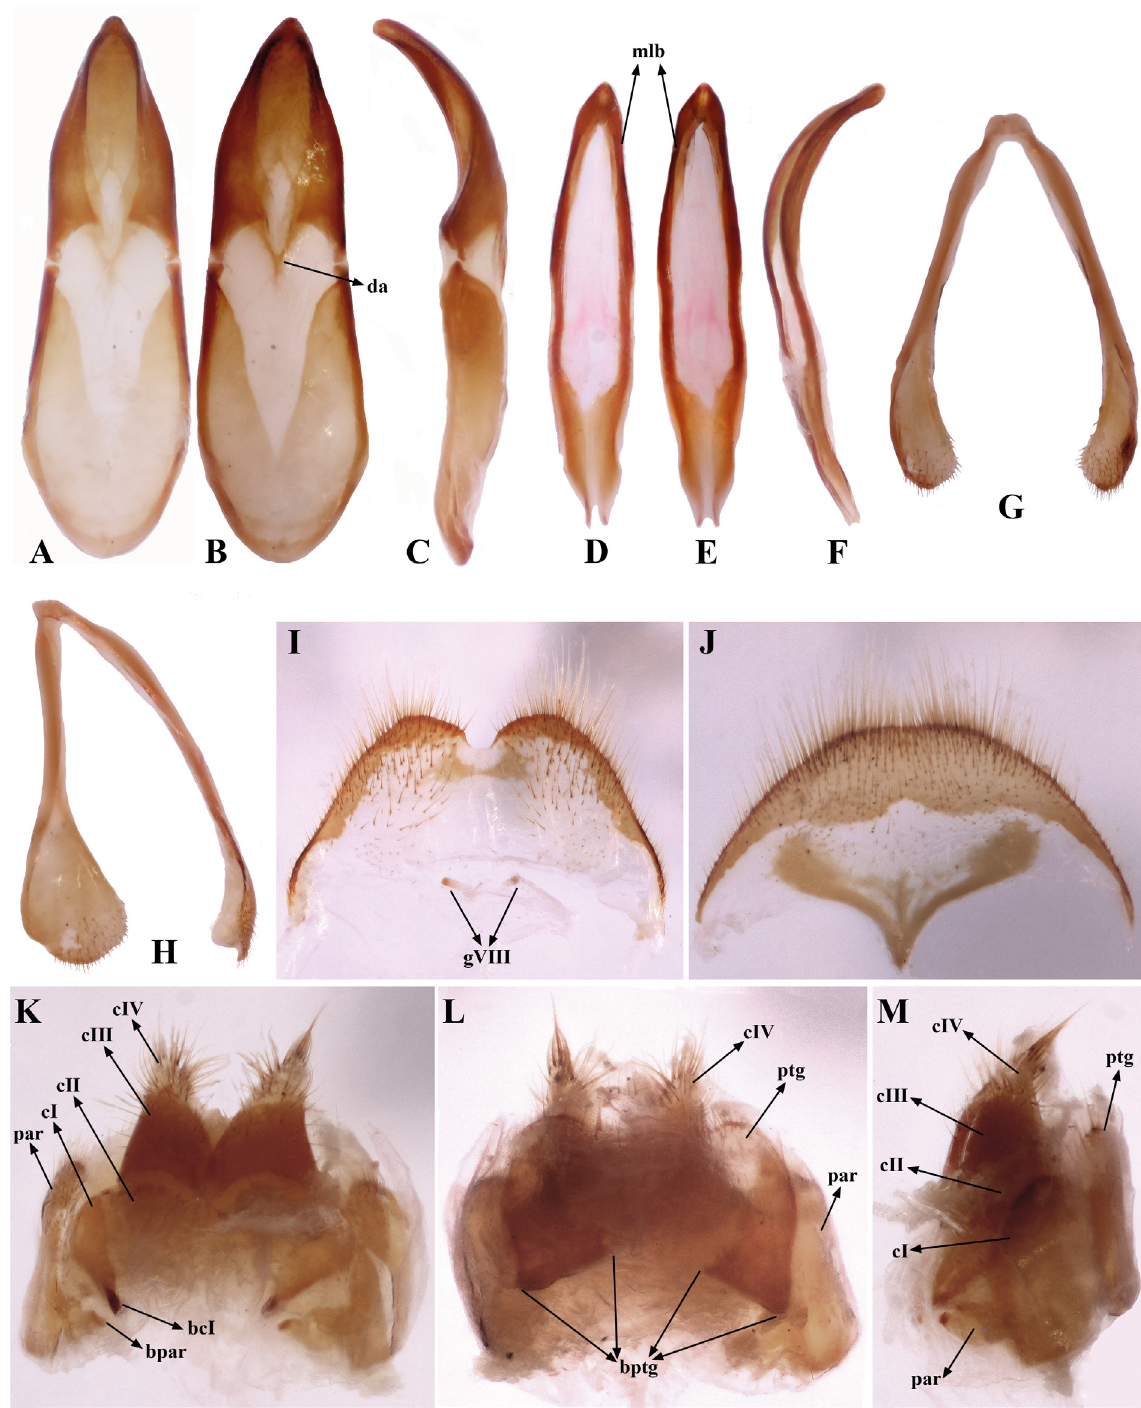
Fig. 16. Habrobates vernalis Semenov, 1903, genitalia (ZIN). A . Tegmen of aedeagus, ventrally. B . Ditto, dorsally. C . Ditto, laterally. D . Median lobe, ventrally. E . Ditto, dorsally. F . Ditto, laterally. G . Spiculum gastrale. H . Ditto, ventro-lateral view. I . ♂, inner sternite VIII. J . ♀, inner sternite VIII and spiculum ventrale. K . Ovipositor, ventrally. L . Ditto, dorsally. M . Ditto, laterally. Not to scale. Abbreviations: see Material and